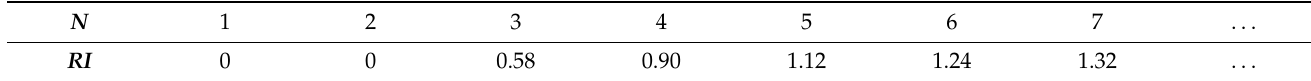
Table 3. The RI values for various N